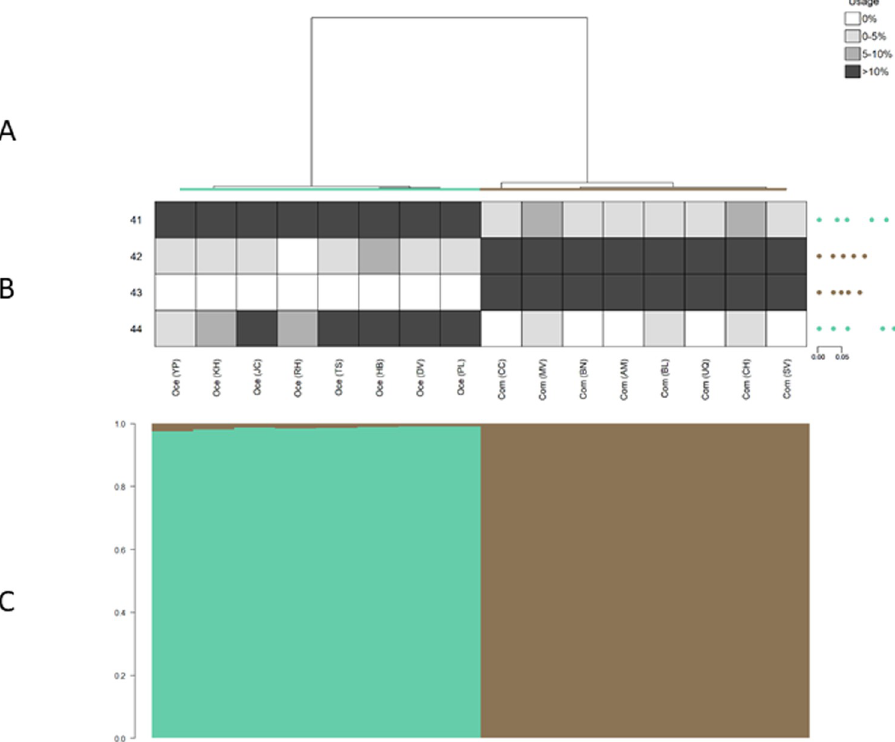
Fig 3. Identity clades, identity song types, and posterior probabilities of repertoire assignment for crickets. Output from IDcall (top; taken from [14]) depicts similarity among male Teleogryllus cricket calling songs recorded from individuals derived from 16 field sites in Australia (data from [17]). ‘Oce’ indicates song repertoires recorded from crickets belonging to the oceanicus species (in teal). ‘Com’ denotes song repertoires recorded from crickets belonging to the commodus species (in brown). The letters in parentheses denote field sites (see [17] for site abbreviations). For each song, we created an interval vector comprised of four traits: chirp pulse length, chirp interpulse interval, chirp-trill interval, and trill pulse length (see [17] for details on how song traits were measured). Each repertoire (i.e. branch in the dendrogram) contains all the songs recorded from first-generation crickets that were derived from wild-caught individuals from each field site. (A) The average linkage hierarchical clustering dendrogram thus depicts similarity among song interval vectors of male crickets from the 16 sites. (B) The heatmap shows identity song type usage (rows) for each field site (columns) in shades of grey, with usage calculated based on probabilistic assignment of songs to types. Identity song type codes are on the left of the heat map and centroid song interval vector plots are on the right (with the spaces between the dots representing chirp pulse length, chirp interpulse interval, chirp- trill interval, and trill pulse length, and the scale bar in seconds). (C) The output from IDcallPP shows the posterior assignment probabilities of each repertoire belonging to each identity clade (i.e. species) as a stacked bar plot. See [14] and [17] for additional